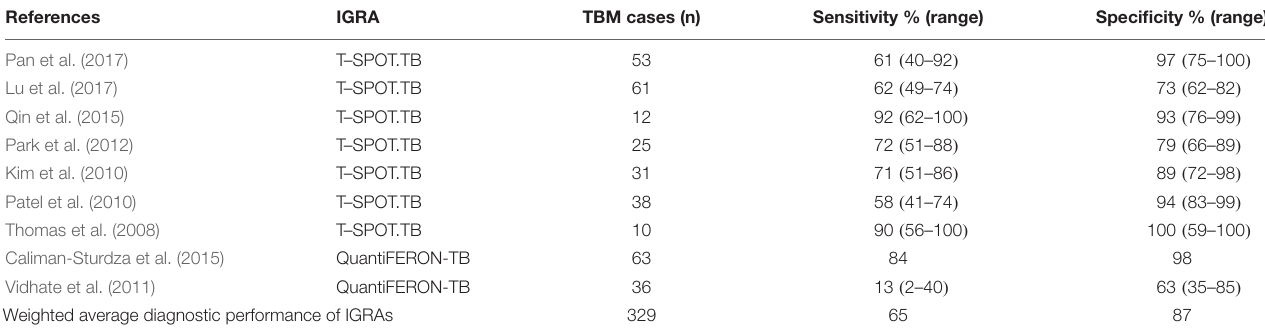
TABLE 3 | Performance of IGRAs on CSF from TBM cases as a stand-alone diagnostic